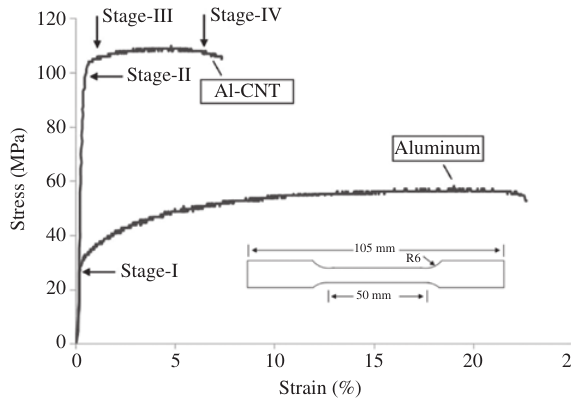
Figure 1: Superimposed tensile stress-strain curves of annealed aluminum and Al-CNT composite. Inset is an image of the fin- ished tensile specimen used for the testing according to ASTM